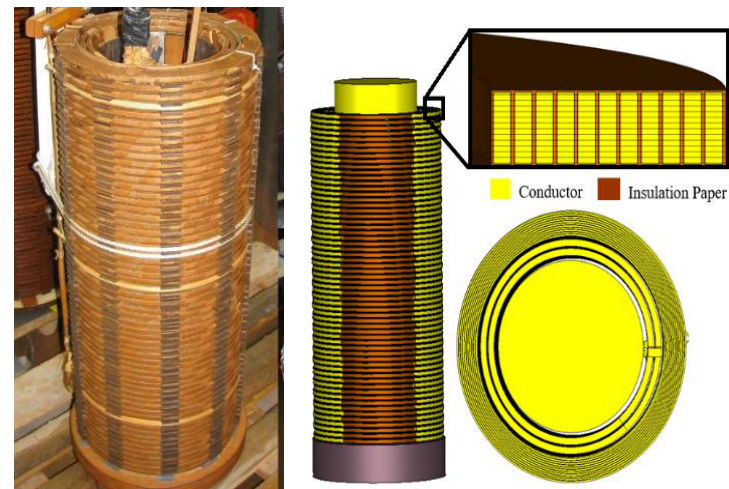
Figure 8. Experimental setup ( left ) and CST model ( right ).